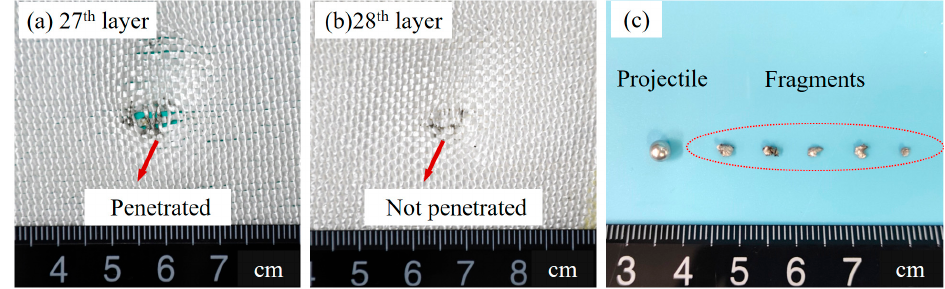
Figure 6. UHMWPE fabrics and projectile fragments. ( a ) 27th layer. ( b ) 28th layer. ( c ) Fragments remaining in fabric.